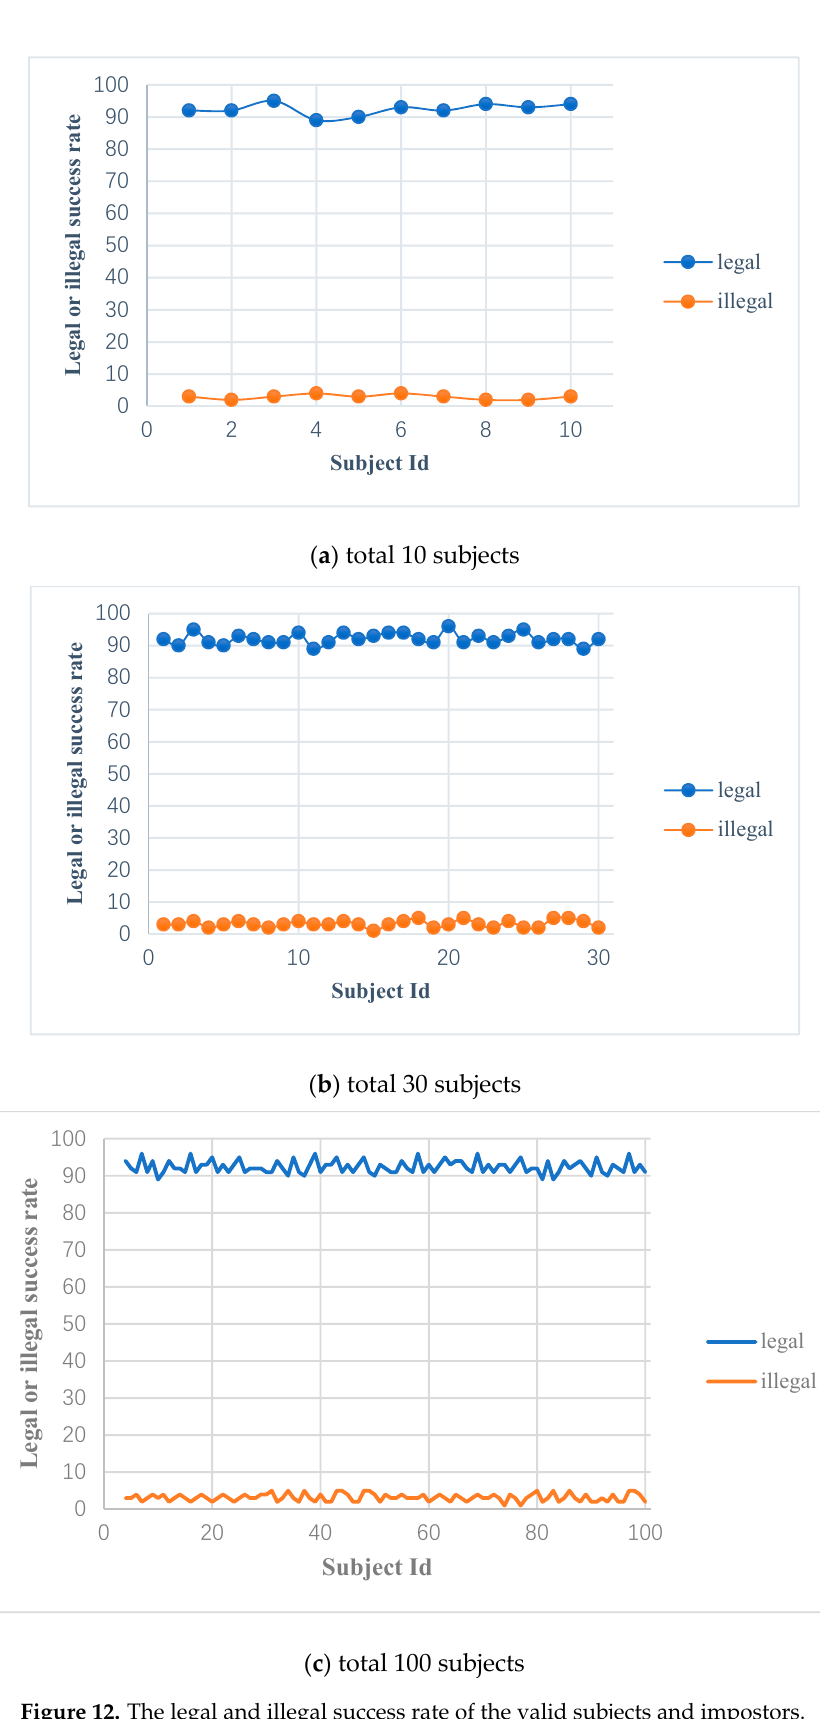
Figure 12. The legal and illegal success rate of the valid subjects and impostors.